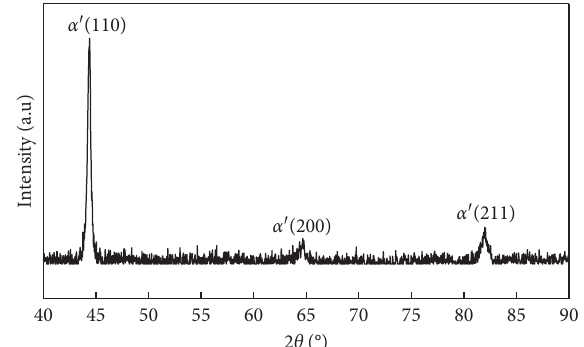
Figure 14: X-ray diffraction pattern of the hardened specimen of the